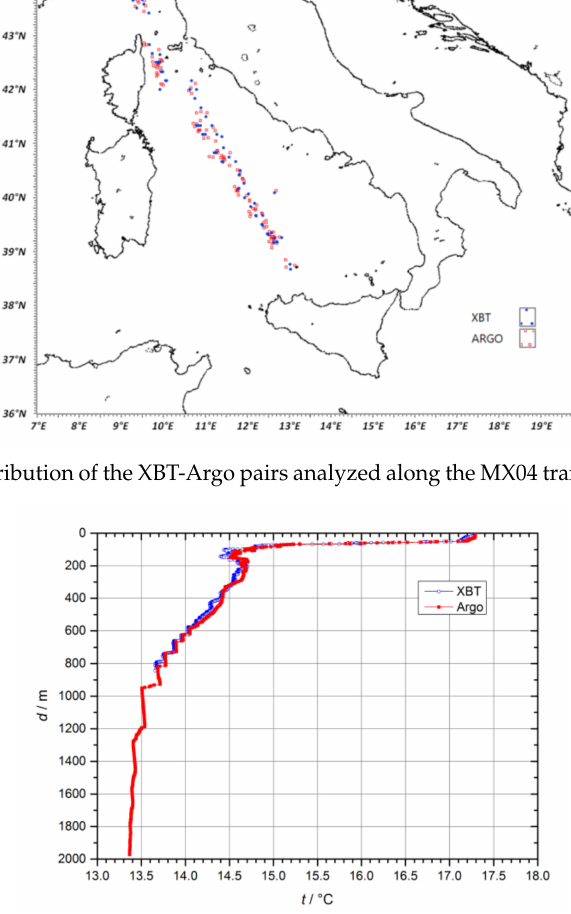
Figure 3. Example of quasi-collocated and quasi simultaneous XBT and Argo profiles. XBT (Deep Blue)—Date: 2018 / 12 / 11, Time: 14:05:50, Lon: 12.6322 ◦ E, Lat: 39.1667 ◦ N. Argo (#6902903)—Date: 2018 / 12 / 14, Time: 10:19:00, Lon: 12.6344 ◦ E, Lat: 39.2362 ◦